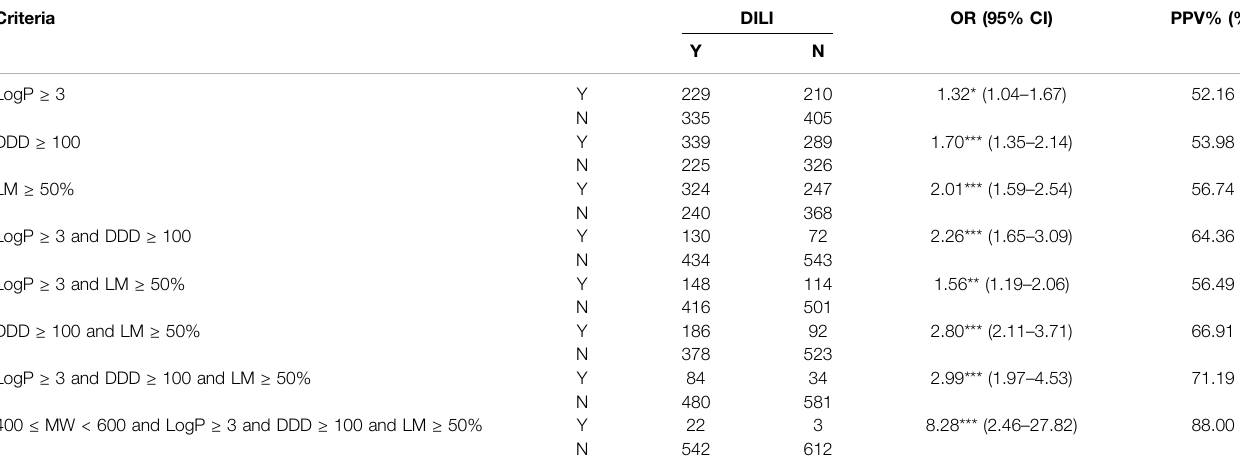
TABLE 1 | Associations between different risk criteria and drug-induced liver injury (DILI). Criteria